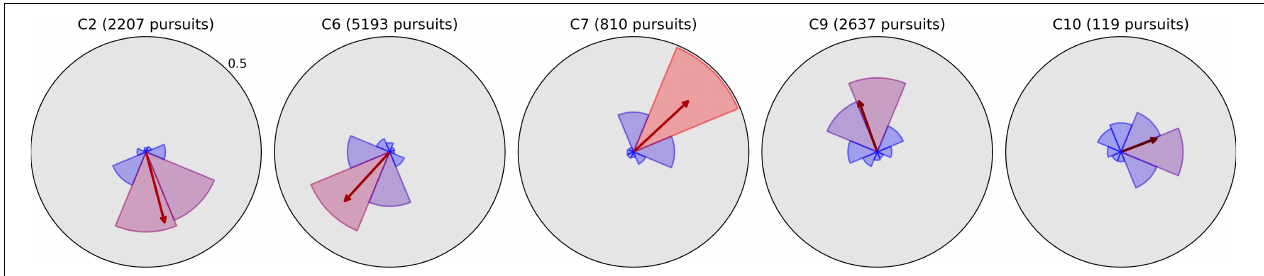
FIGURE 6 | Radial histograms of pursuit frequency and mean bias vectors in Field Bubbles for the same five children whose plots have gray backgrounds in Figure 4 (the same histograms from Moving Bubbles). All elements have the same meaning as in Figure 4 and are essentially identical to that figure for each of the five children despite the absence of moving stimuli Field Bubbles, indicating that their pursuits are likely caused by involuntary nystagmus.